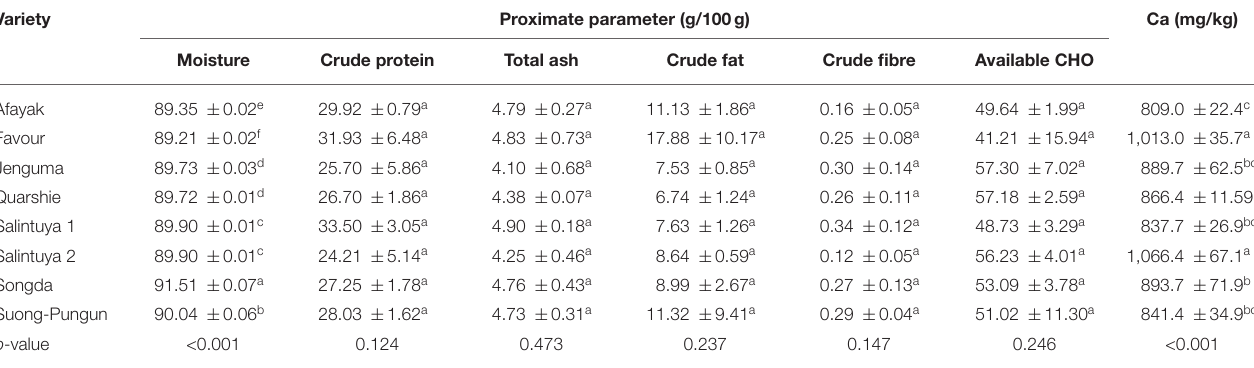
TABLE 1 | Compositional characteristics of soymilk as influenced by variety. Variety Proximate parameter (g/100g) Ca (mg/kg) Moisture Crude protein Crude fat Crude fibre Available CHO